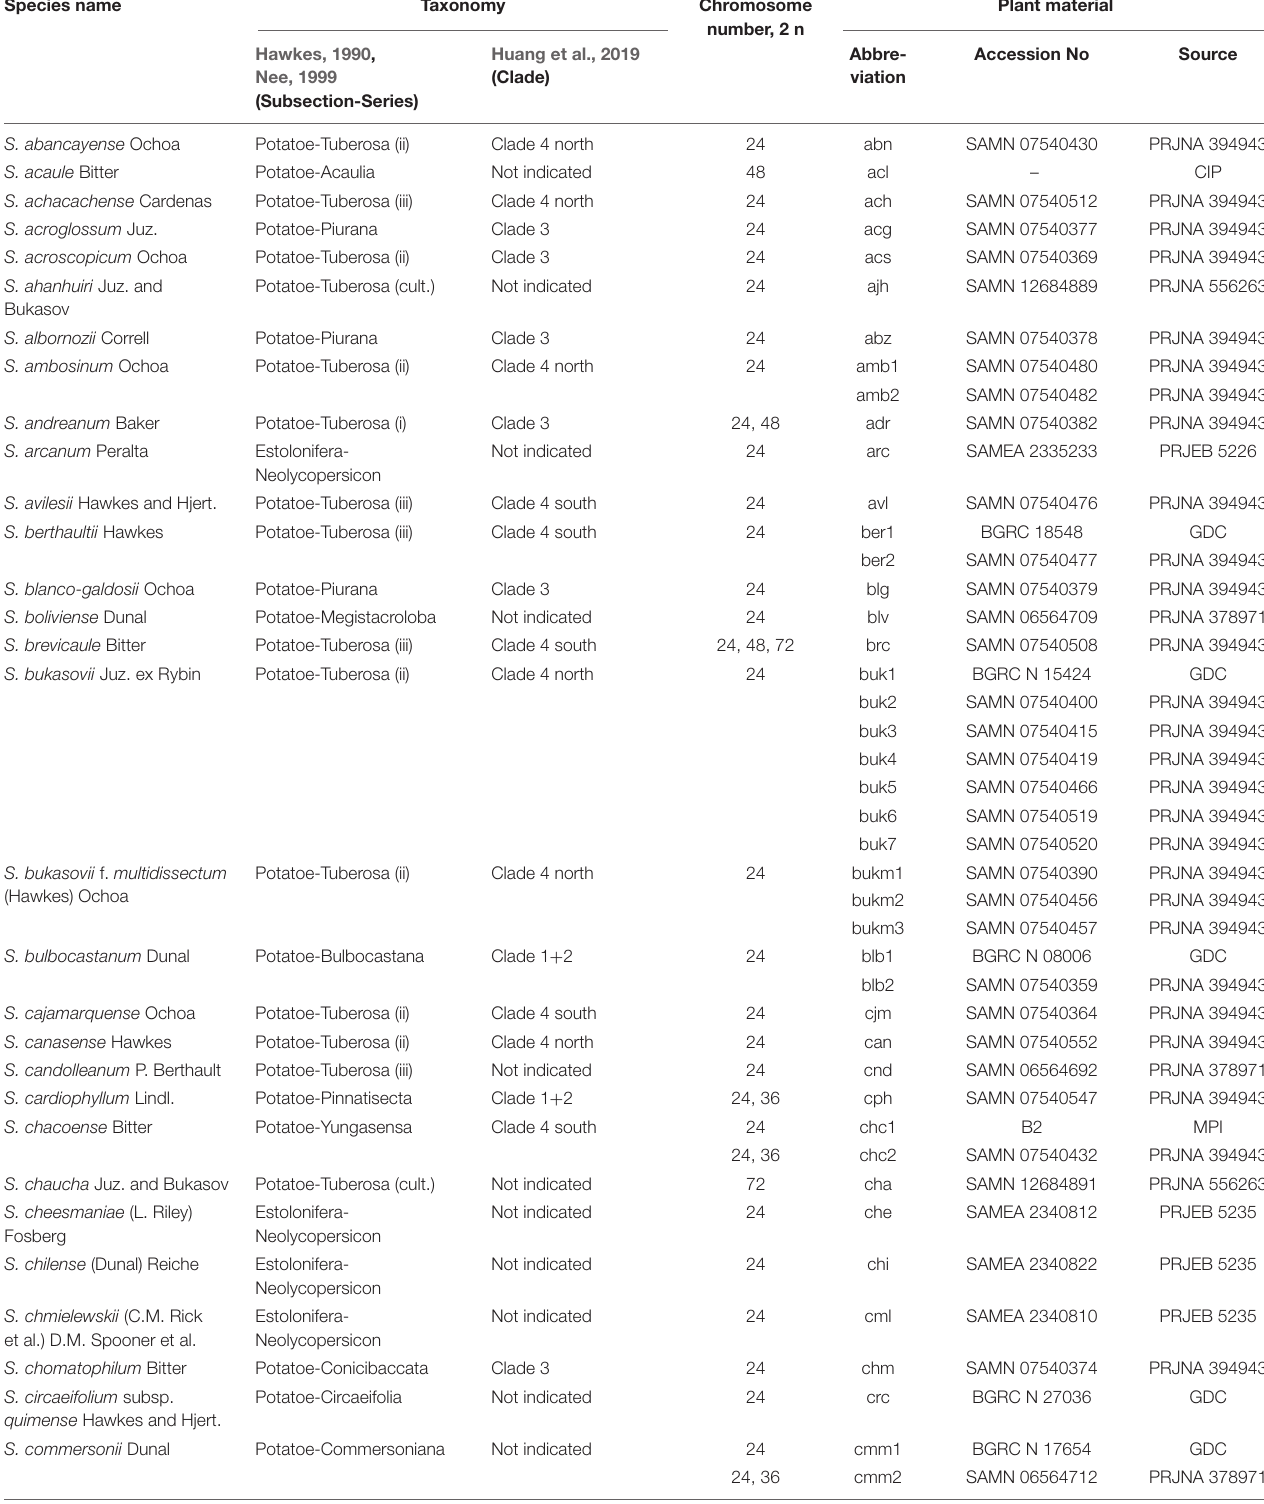
TABLE 2 | List of analyzed Solanum species of sect. Petota